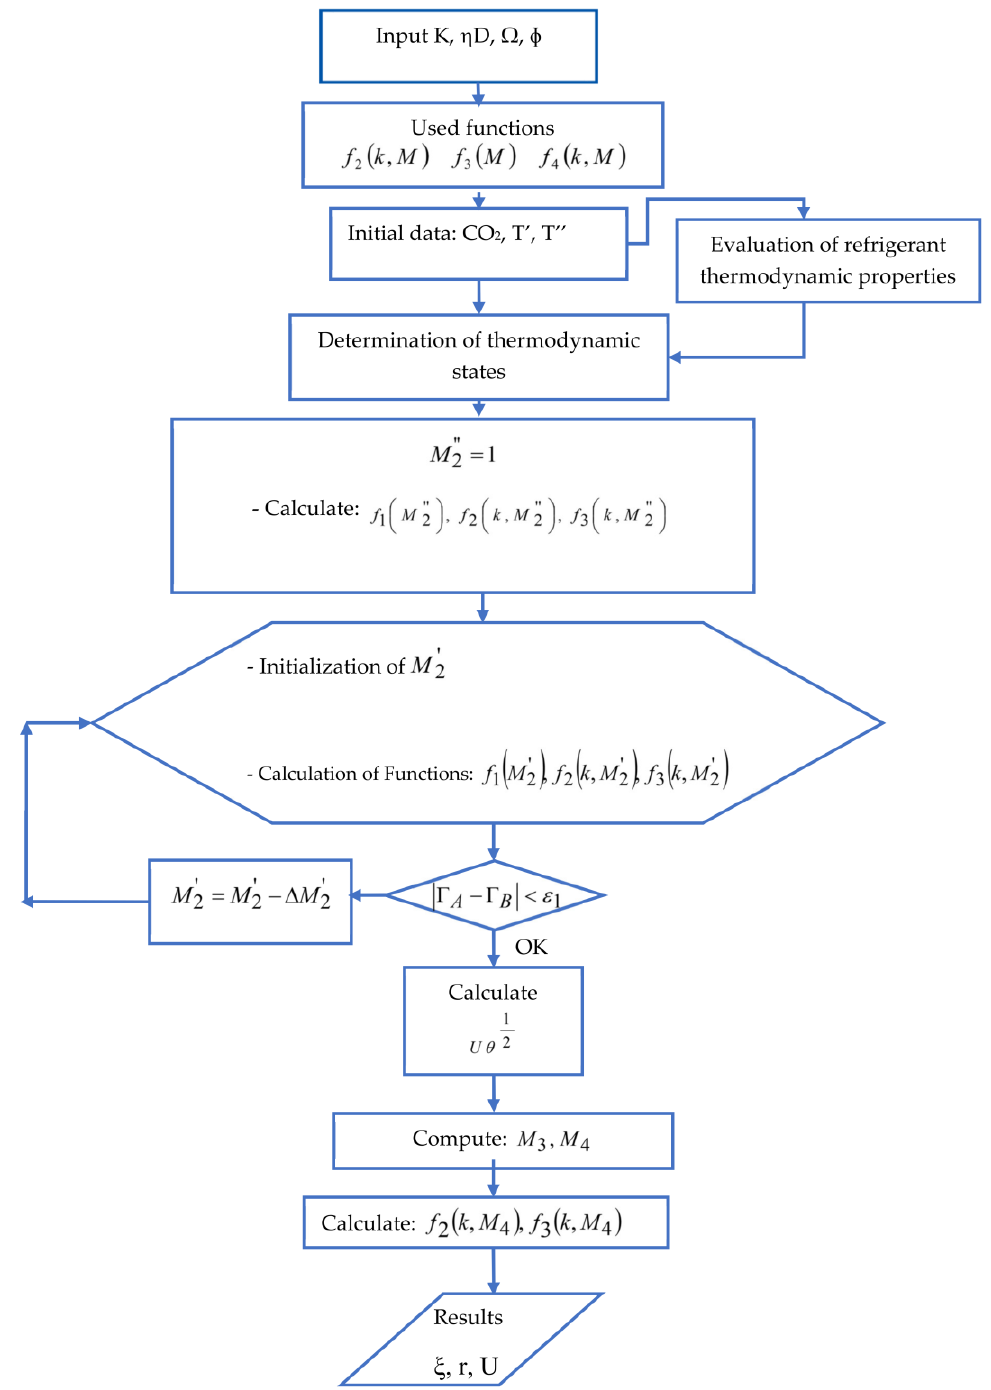
Figure 4. Ejector calculation flow